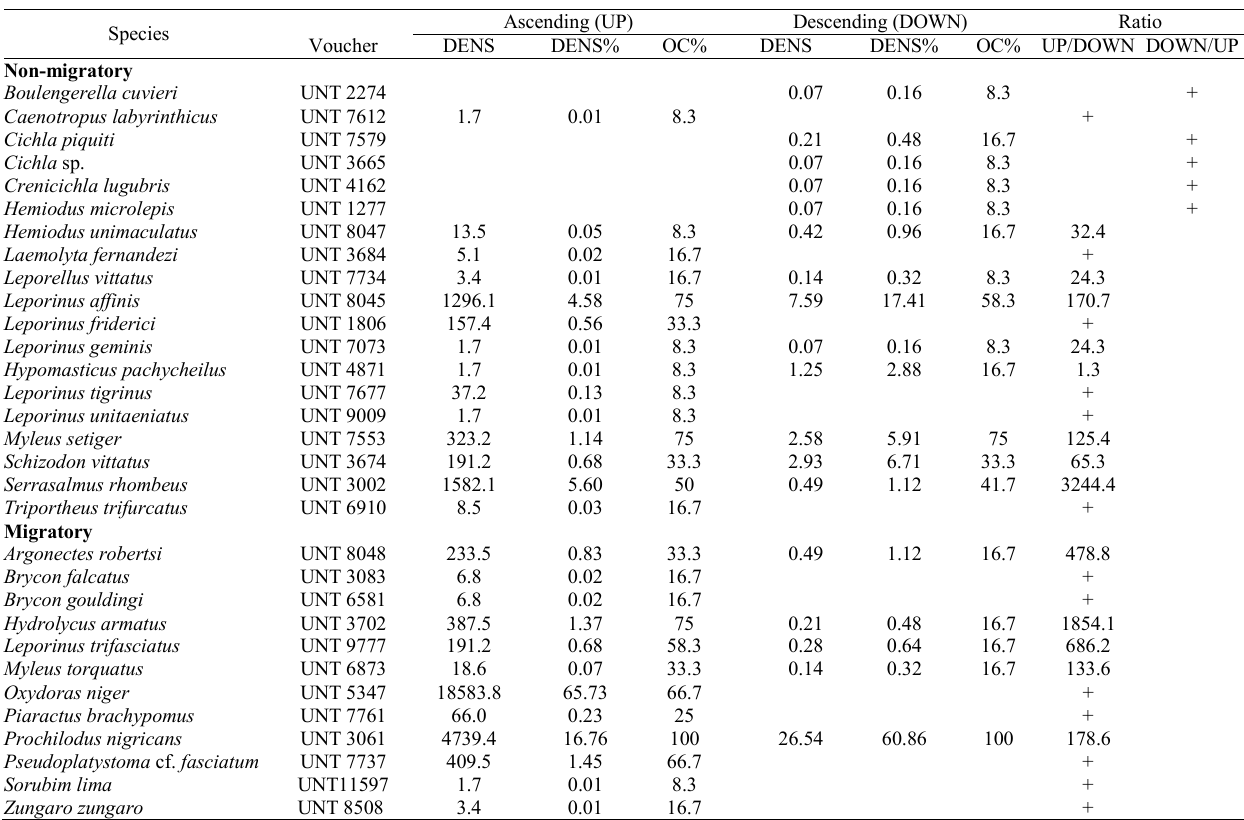
Table 2. Mean density (DENS: fish/100m 2 ), relative density (DENS%) and occurrence (OC%) of species ascending and descending the ladder for monthly captures between September 2009 and August 2010. The ratio between ascending and descending fish (ind./m 2 ; UP/DOWN and DOWN/UP) is also shown. The symbol “+” indicates one-way movements.